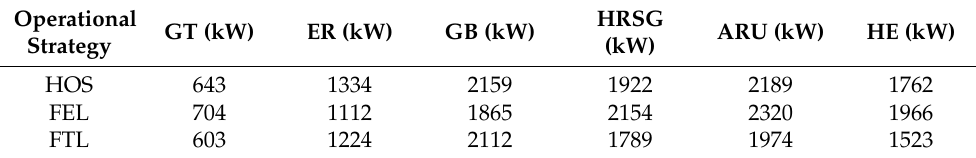
Table 4. The equipment capacity optimization results of three operational strategies. Operational Strategy